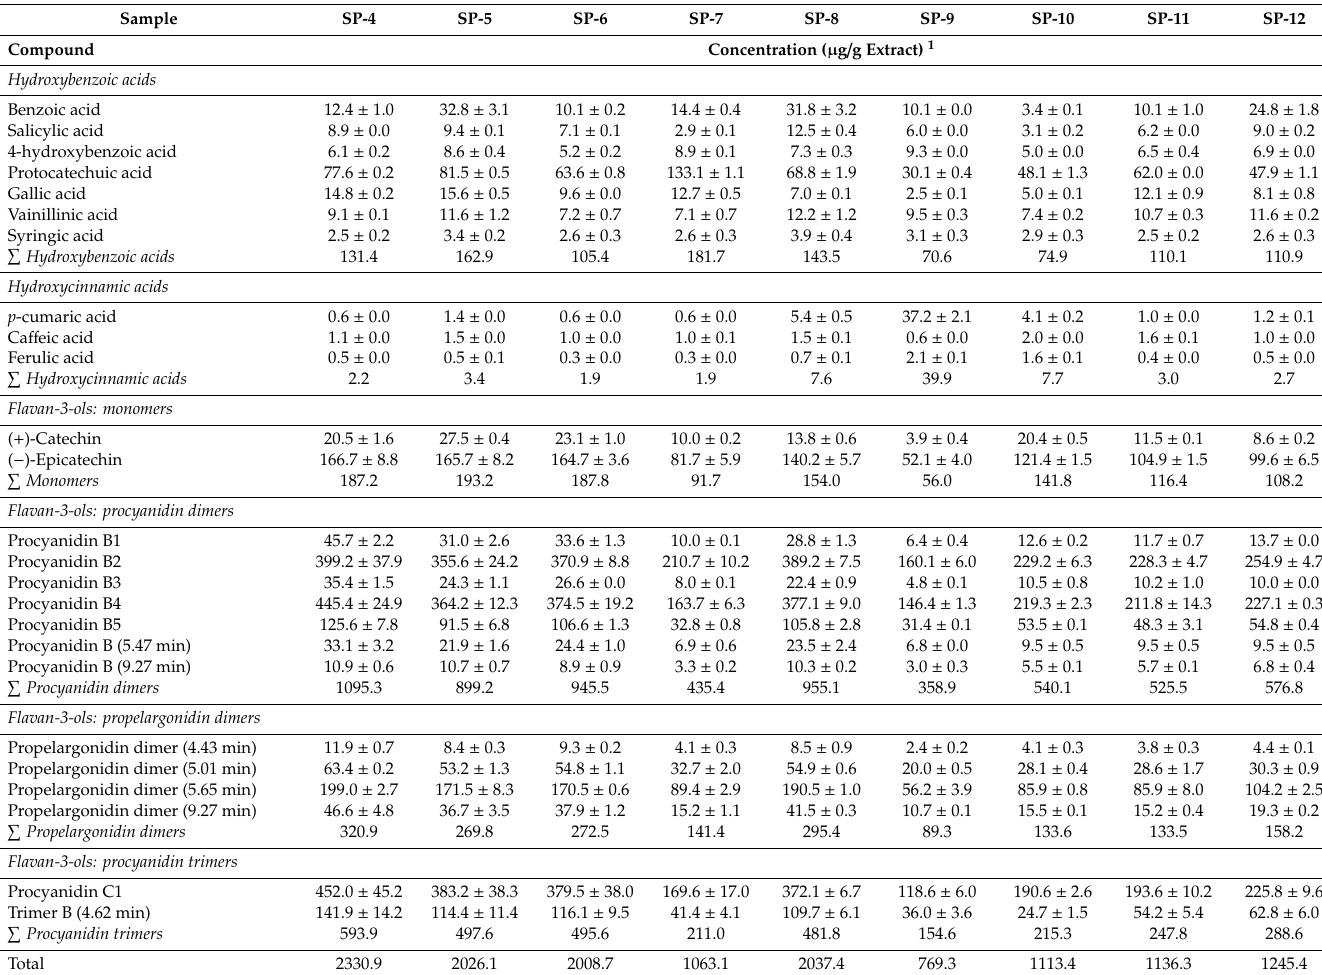
Table 6. Phenolic composition of U. tomentosa bark commercial